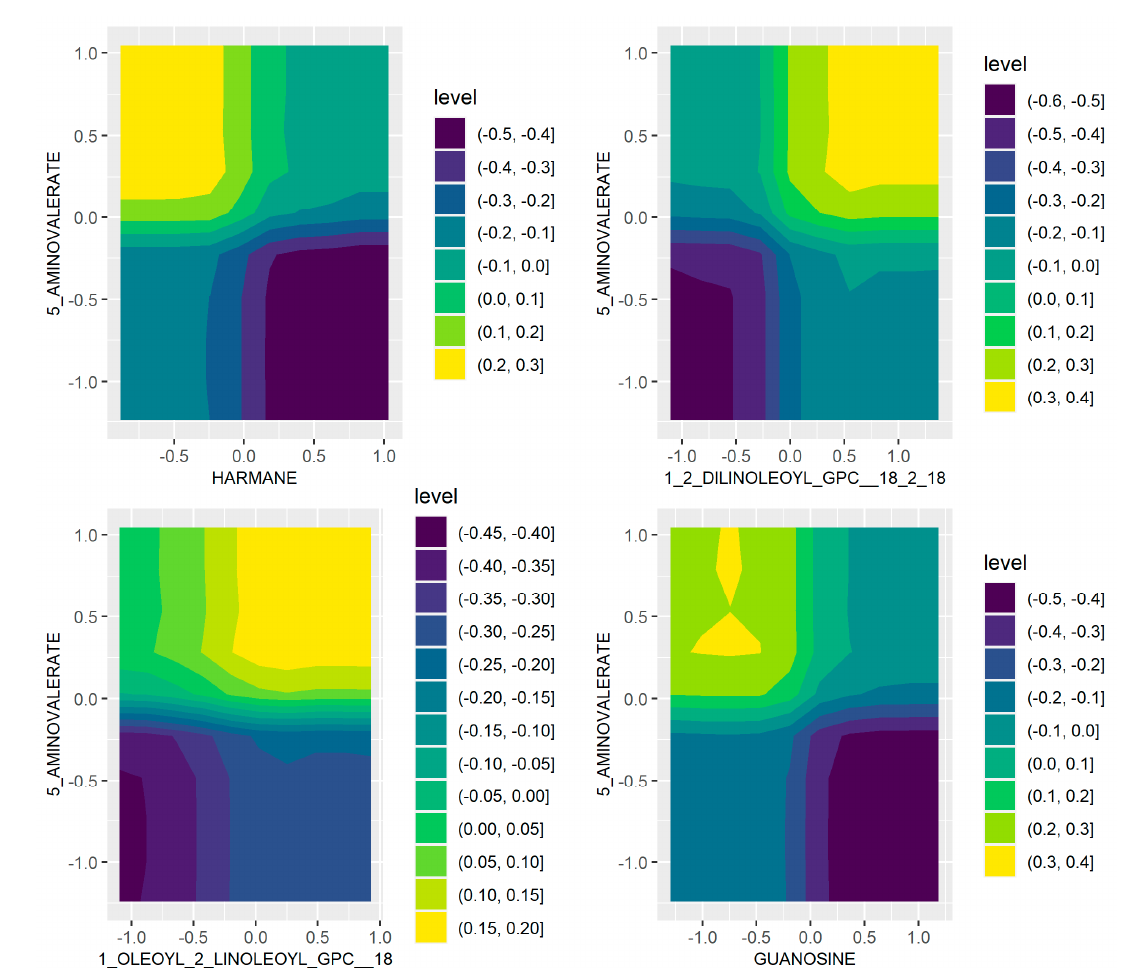
Figure 2. Partial dependence on CRC for representative pairs of microbial/metabolomic features, shown as contour plots, coloured by log-odds of CRC. Higher values (yellow) indicate increased risk of CRC; lower values (blue) indicate decreased risk of CRC; a value of 0 indicates the risks are equal. Plots for more feature pairs can be found in Supplementary Figure S2. Top to bottom: (5-aminovalerate, harmane), (5-aminovalerate, 1,2-Dilinoleoyl-GPC), (5-aminovalerate, 1-oleoyl-2-linoleoyl- GPC), (guanosine,